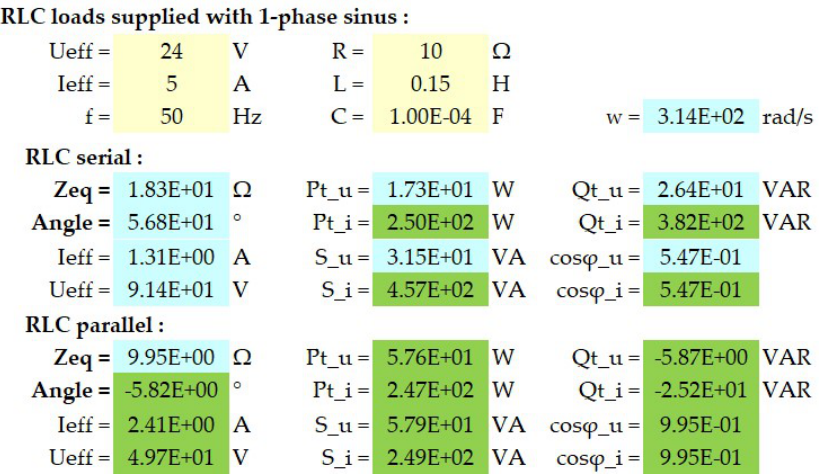
Figure 4. Results obtained with the RLC parallel calculating